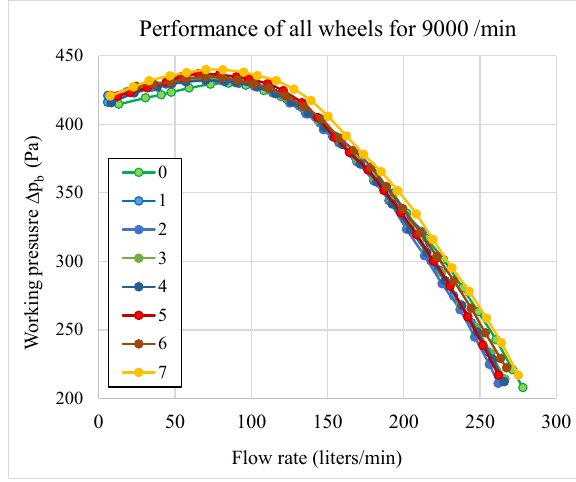
Fig. 9 Fan output for all wheels for motor speed 9000 /min corrected according outlet width